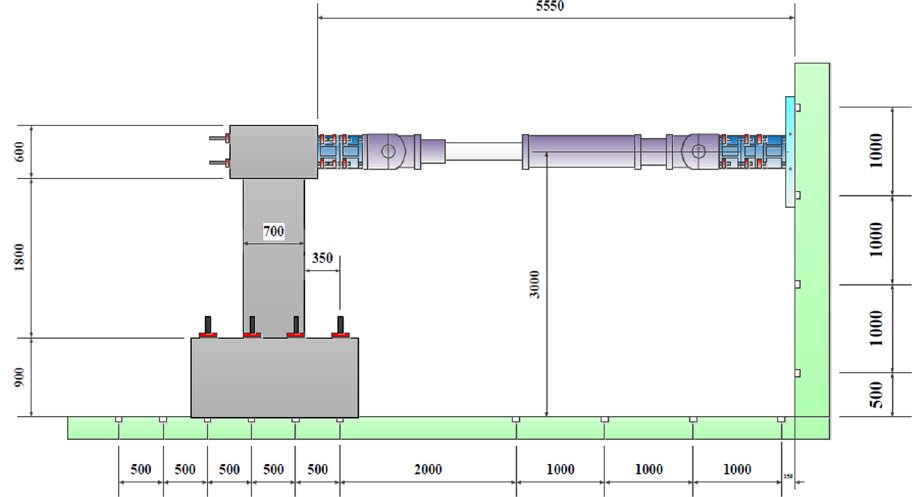
Fig. 6 Applied loading system for the cantilever beam specimens in this work (unit: